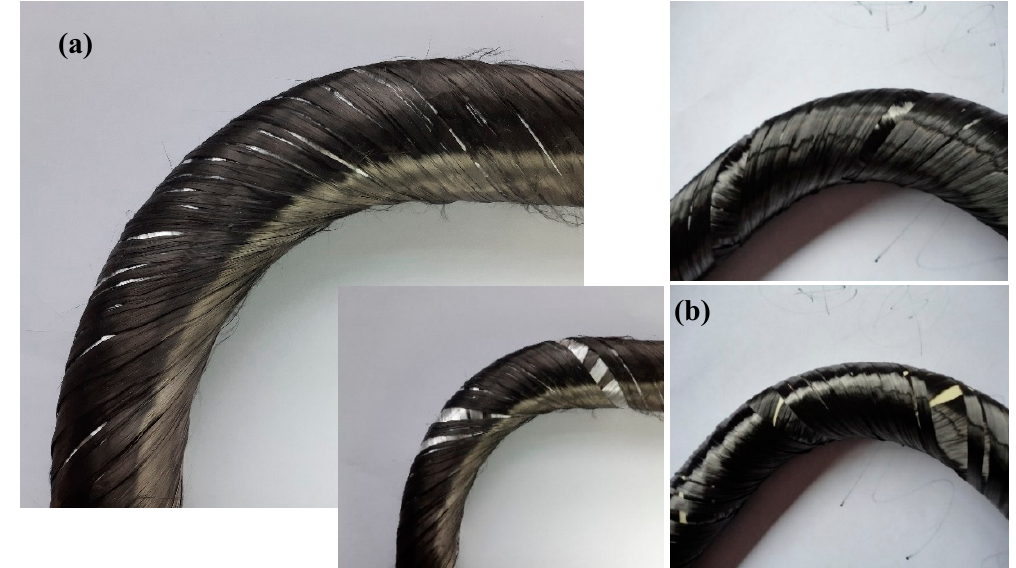
Figure 14. Image of the polymer composite frames wound using ( a ) the new and ( b ) manual-robot winding processes.